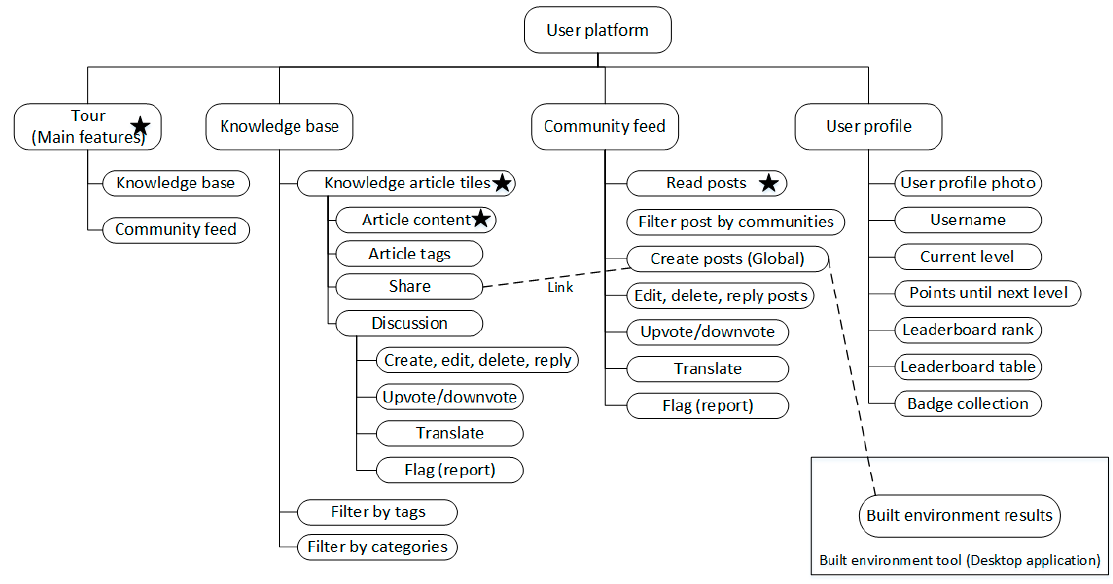
Figure 1. KCP high-level features–non-registered vs. registered